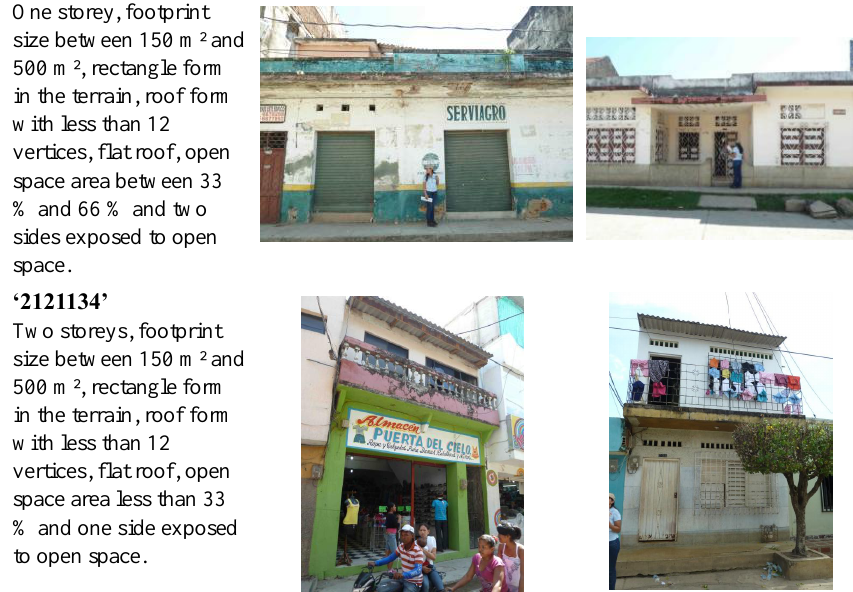
Figure 3. Examples of building constructions with the taxonomic code according to Table Figure 3: Examples of the building constructions of the taxonomic code according to Table 1